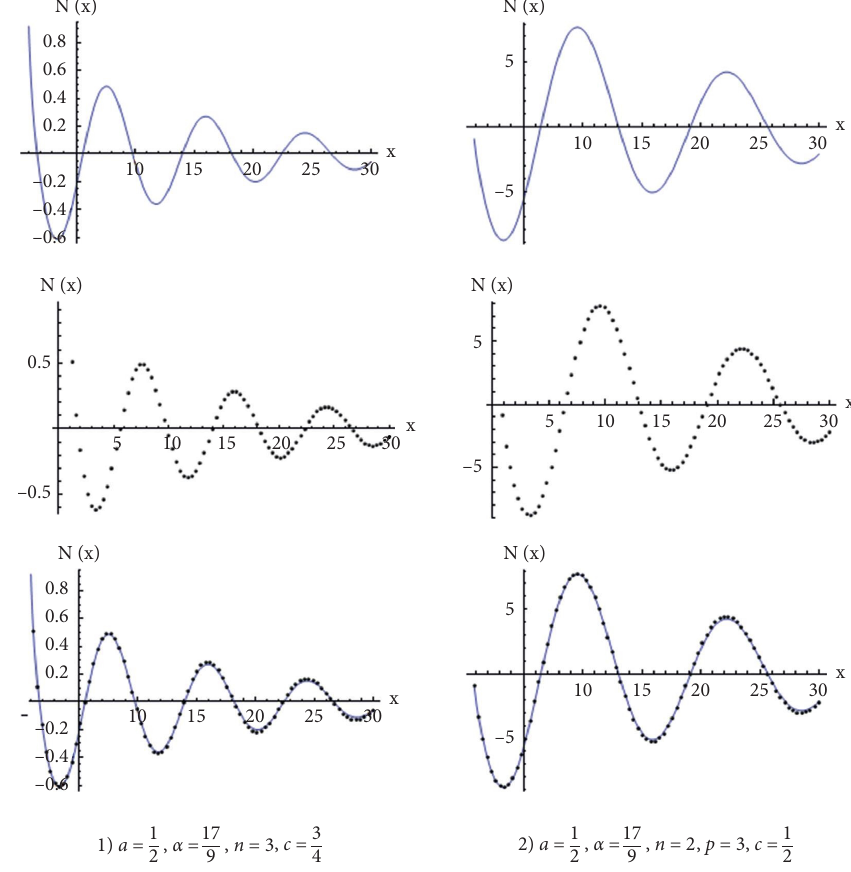
Figure 2: Te analytical solution and the numerical solution of (106) and